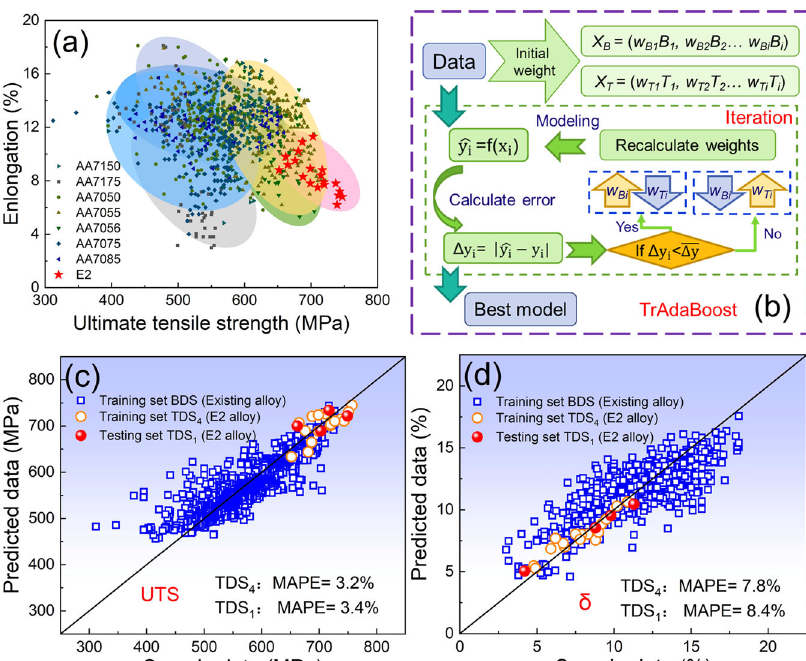
Fig. 2 TrAdaBoost algorithm modeling and model prediction ability. a Scatter diagram of sample properties in the BDS and TDS. b Schematic diagram of the TrAdaBoost algorithm. Where, B i and w Bi are the data and data weight in the BDS data set, T i and w Ti being those in the TDS 4 data set; x i is composition and process parameters and y i is the property of the samples in the BDS data set or the TDS 4 data set; b y i is the predictive property via machine learning model, Δ y is the average value of prediction error; c ultimate tensile strength UTS modeling results; d elongation δ modeling results. Wherein, TDS 4 in Figs. c and d are training sets for 5-fold cross validation.